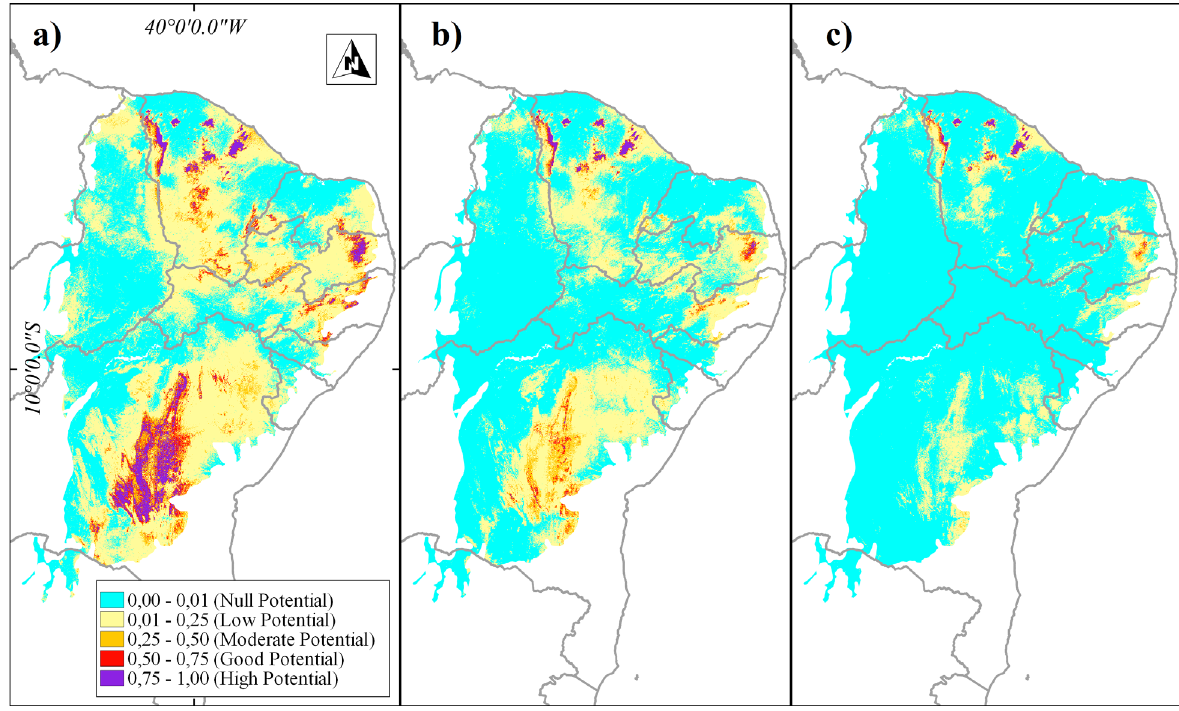
Figure 3. Current spatial distribution (a) and spaces projected for 2050 (b) and 2070 (c) in scenario RCP4.5 for Epiphyllum phyllantus in the Caatinga